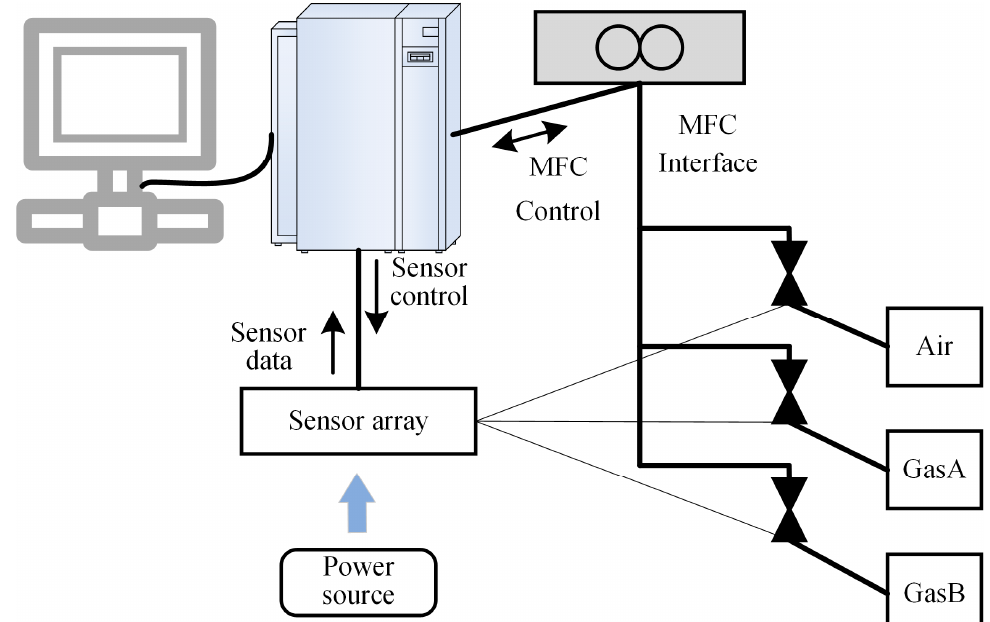
Figure 1. Experimental setup used for data acquisition. Table 1. Sensor types and operating voltages.